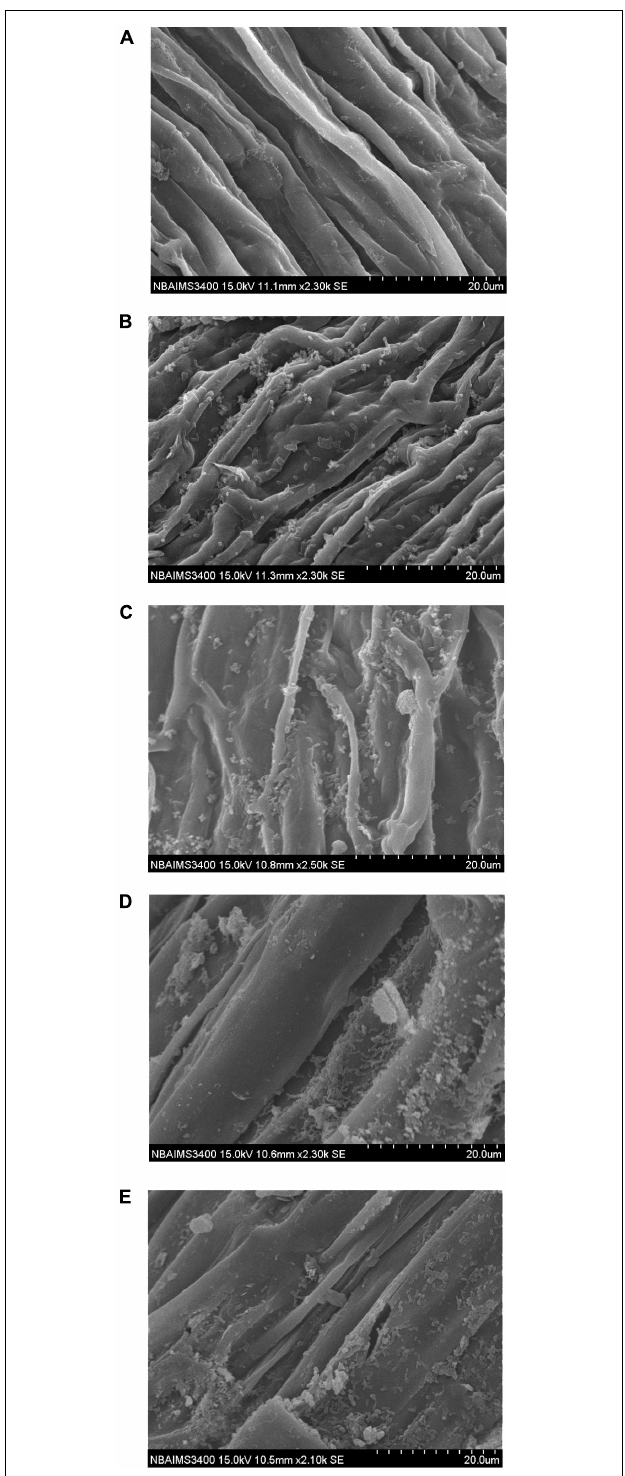
FIGURE 3 | Scanning electron microphotographs showing root colonization and biofilm formation by selected strains under glasshouse conditions, (A) Absolute control, (B) Bacillus glycinifermentans CRS-9, and (C) Microbacterium oxydans CRS-17, (D) Paenarthrobacter nicotinovorans CRS-30, and (E) Bacillus tequilensis